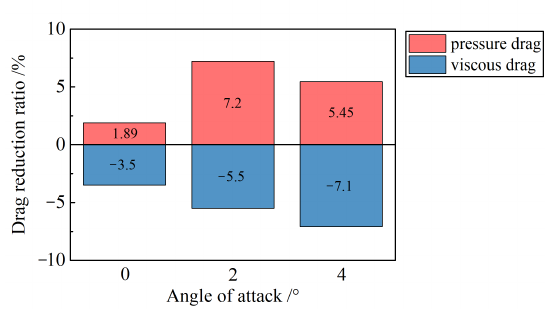
Figure 23. Reduction ratios of pressure drag and viscous drag.